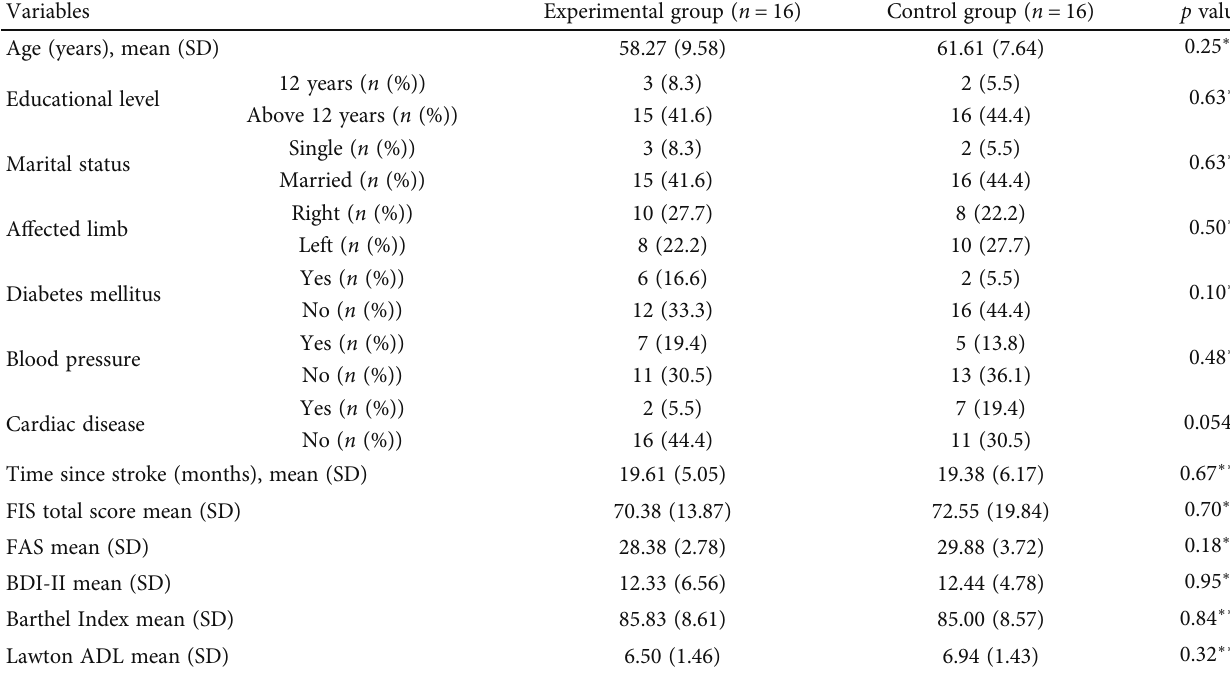
Table 1: Demographic, clinical characteristics, and group di ff erences of the participants in experimental ( n = 16 ) and control ( n = 16 ) groups at baseline.